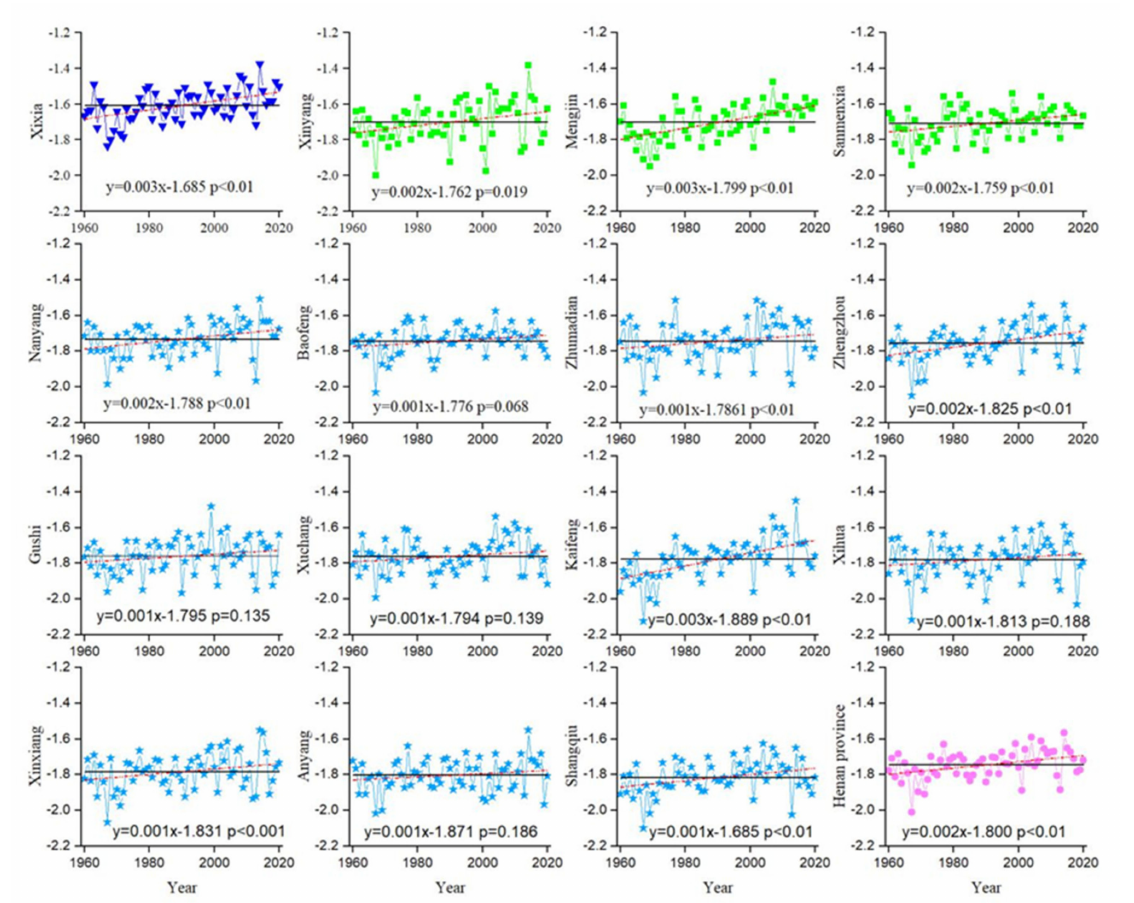
Figure 3. Interannual variation of the TCCI of meteorological stations in Henan Province and the whole province (average of all